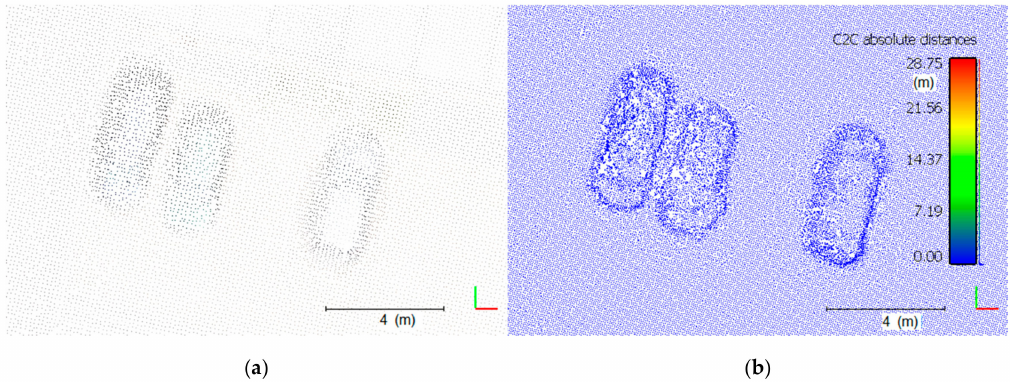
Figure 6. Point-cloud details visual comparison (cars in a parking place) for ( a ) Mavic Pro 100 m and ( b ) Mavic Pro SR.